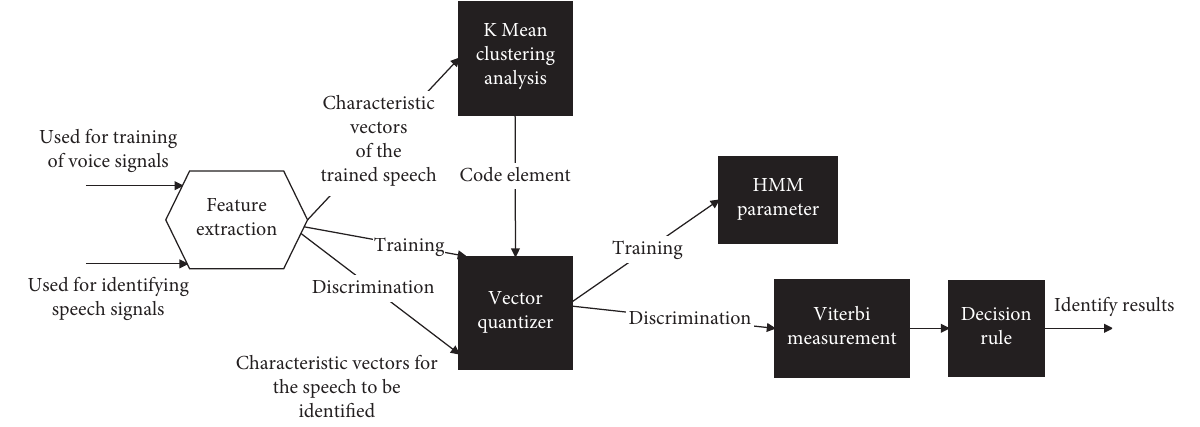
Figure 3: HMM music frame recognition